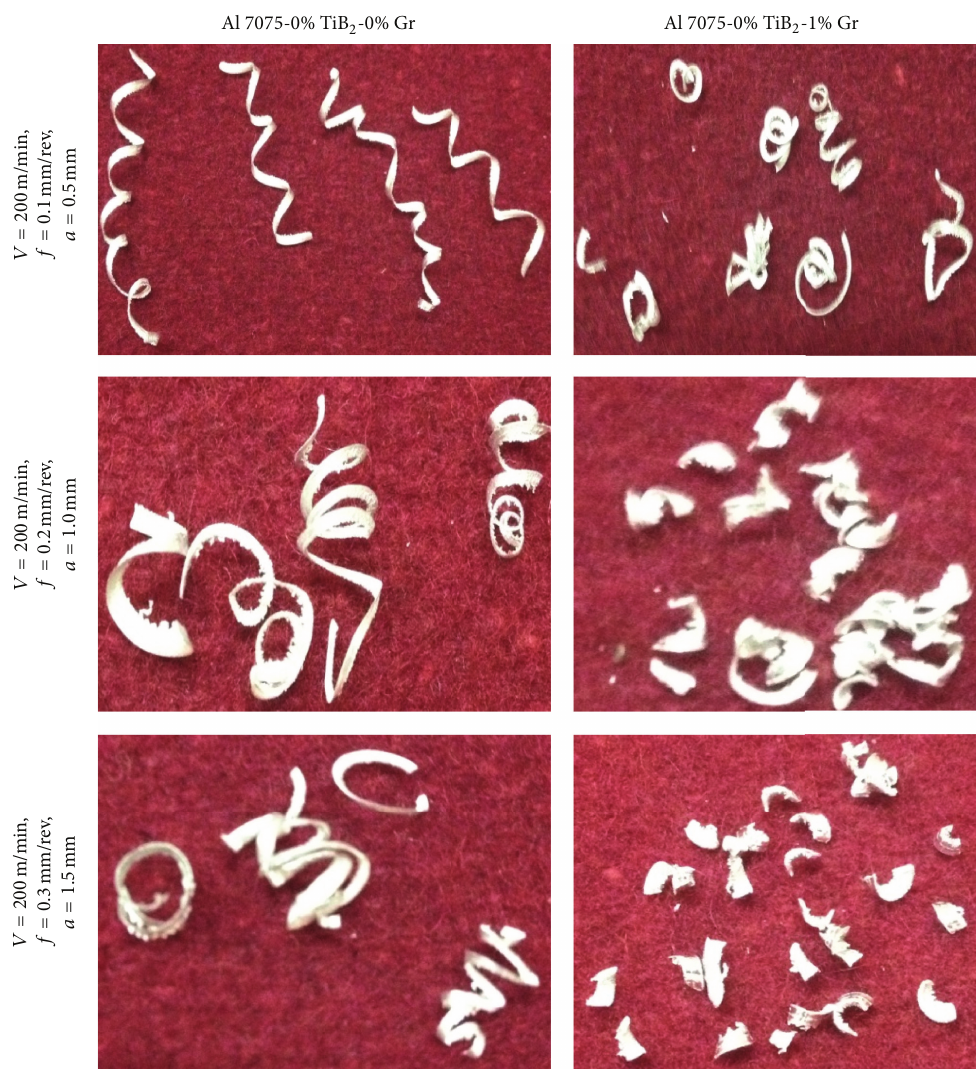
Figure 12: Examination of chip morphology with selected cutting parameters of Al 7075-3% TiB 2 -0% Gr and Al 7075-3% TiB 2 -1% Gr hybrid in situ composite with the cutting tool of 0.4 nose radius